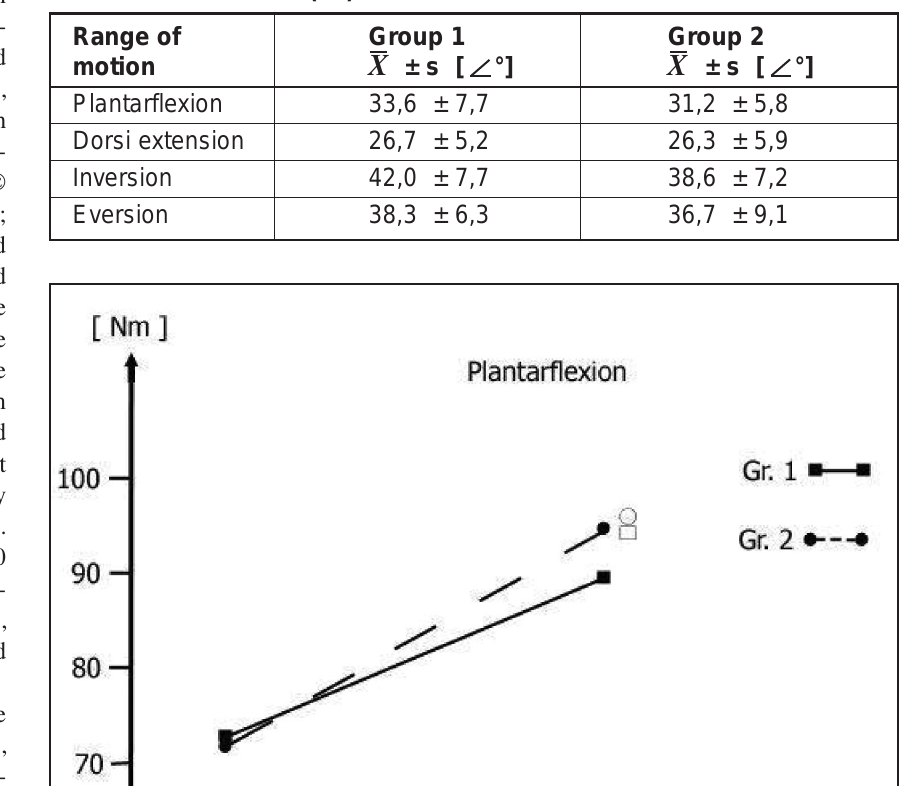
) ( o = maximum isokinetic 2